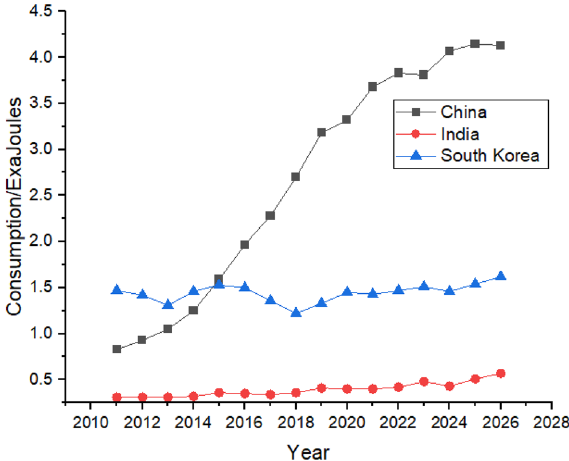
Figure 12. Nuclear energy consumption in Asian Region.